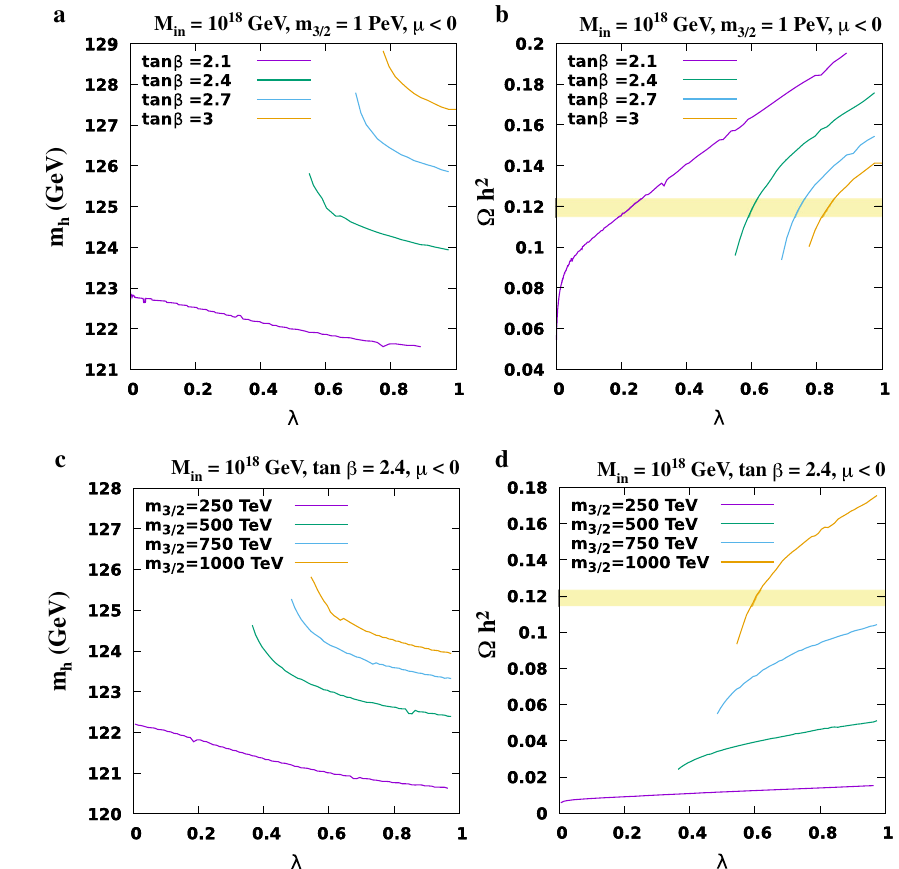
Fig. 1 a , c The Higgs mass m h and b , d the LSP density (cid:23) 2 as functions of the LSP h coupling λ with m 3 / 2 = 10 3 TeV for several values of tan β a , b or fixed tan β = 2 . 4 for several values